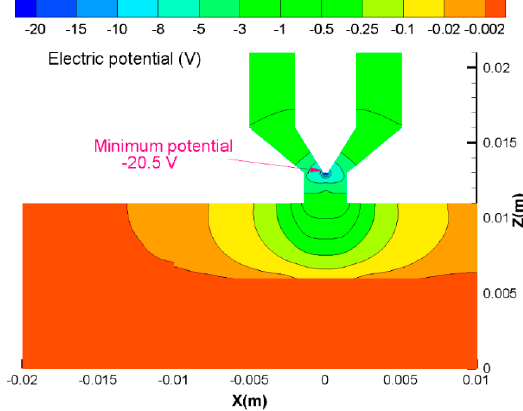
Figure 12. Calculated electric potential on the symmetry.